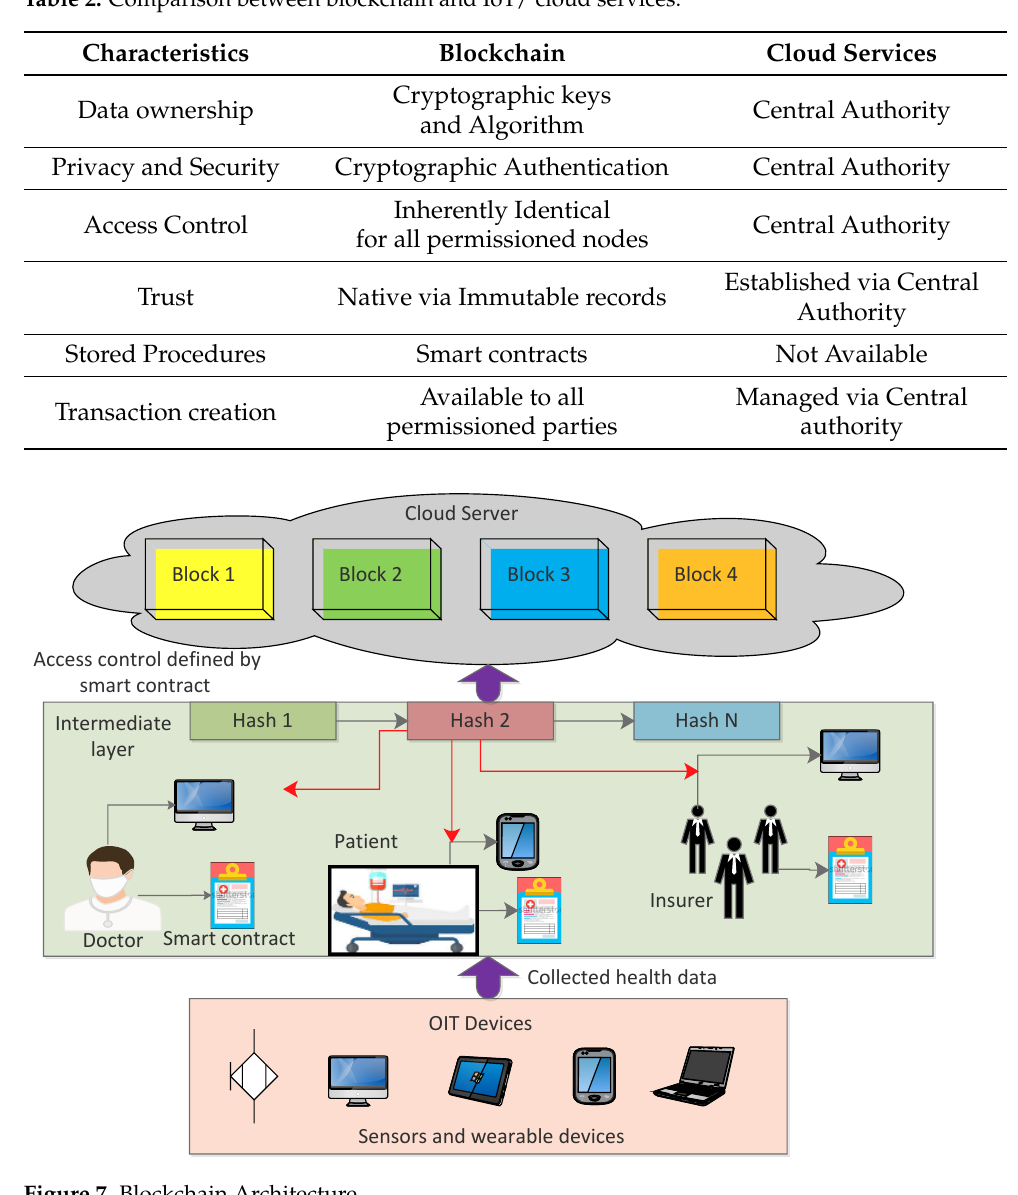
Figure 7. Blockchain